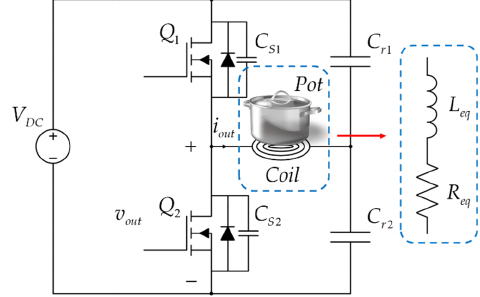
Figure 1. A conventional induction heating (IH) system.